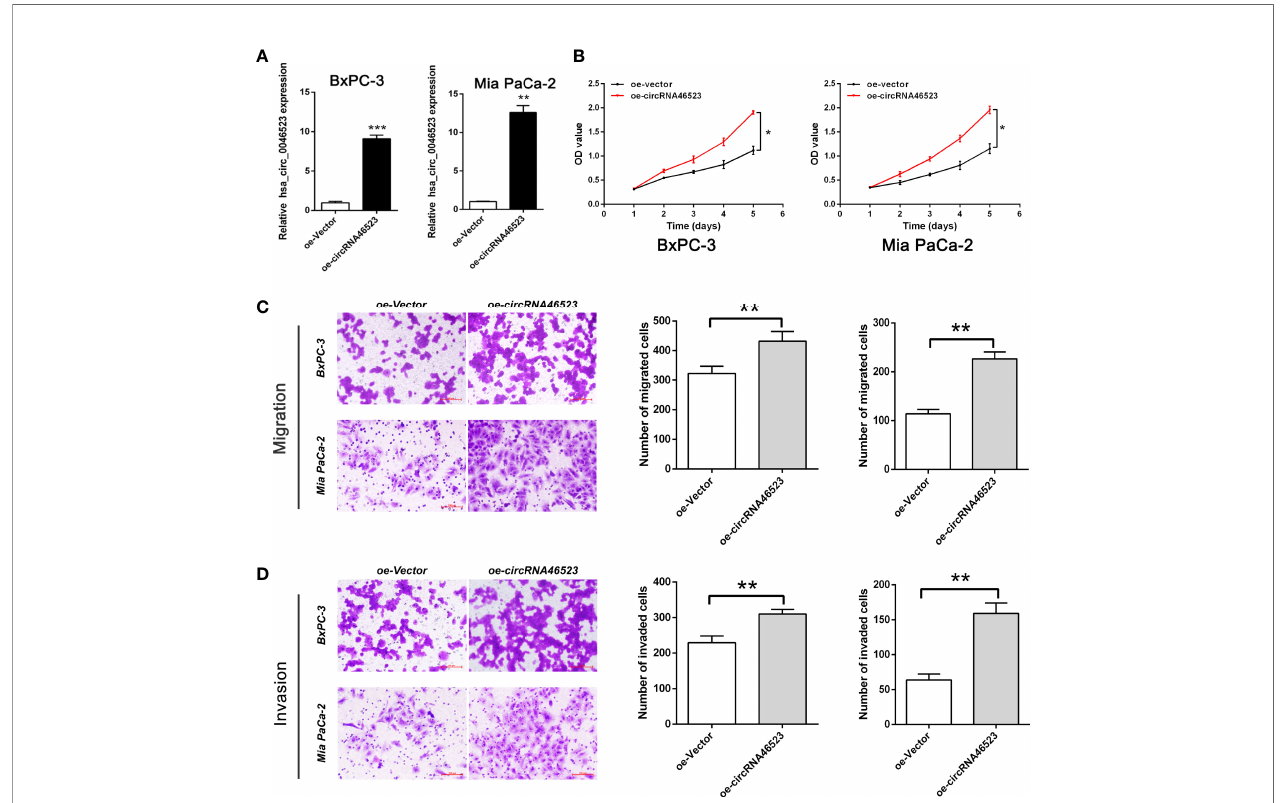
FIGURE 2 | Hsa_circ_0046523 overexpression promoted the proliferation, migration and invasion of PC cells. (A) After infecting lentivirusencodingoe-circRNA46523, the expression level ofhsa_circ_0046523 inBxPC-3 and Mia PaCa-2 cells was con fi rmedusing RT-qPCR analysis. (B) CCK ‐ 8 assayswere conducted to estimatethe effects of hsa_circ_0046523 overexpression on theproliferation of BxPC-3 andMia PaCa-2 cells. (C,D) Transwellassayswereconductedto estimatetheeffects ofhsa_circ_0046523 overexpression onthe cell migration and invasion capacities of BxPC-3 and Mia PaCa-2 cells. Data were expressed as means± SDofthree independent experiments. * P < 0.05, ** P < 0.01, *** P <